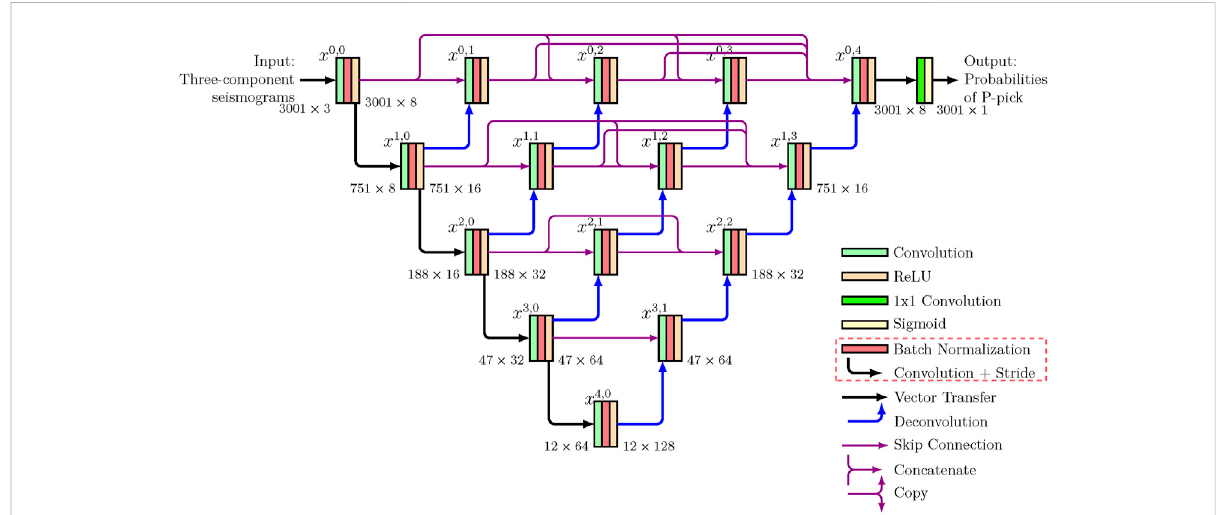
FIGURE 5 Structure of CSESnet earthquake detection network. The rectangular block indicates that operations such as convolution, batch normalization andactivationfunctionsthatconstitutetheconvolutionblock.Thefeaturemapisdenotedby x i , j ;theblackarrowindicatestheconvolutionoperation with stride of four; the blue arrow indicates the deconvolution operation (actually done by transpose convolution); the purple arrow represents the skip connections between the network node modules. The value of the skip connections leading from the same node to different nodes is the same vector for copying (the purple Copy arrow in the legend), and skip connections introduced from different nodes to the same node are feature vectors for the channel dimension concatenate operation (purple Concatenate arrow in the legend). The Batch Normalization and Convolution+Stride in the red dashed box are the improvement parts of the original UNet++ in this